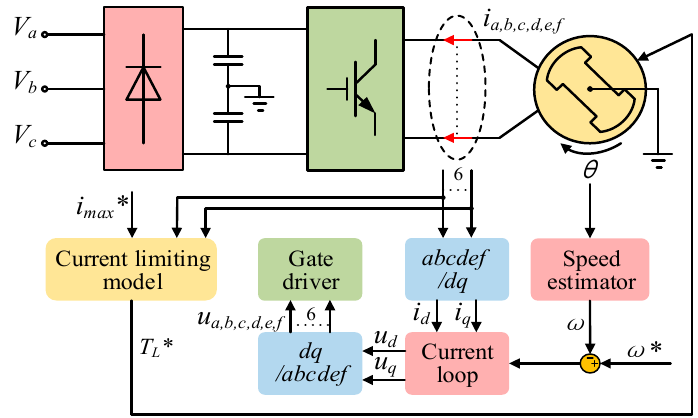
Figure 2. Dual three ‐ phase PMSM system.